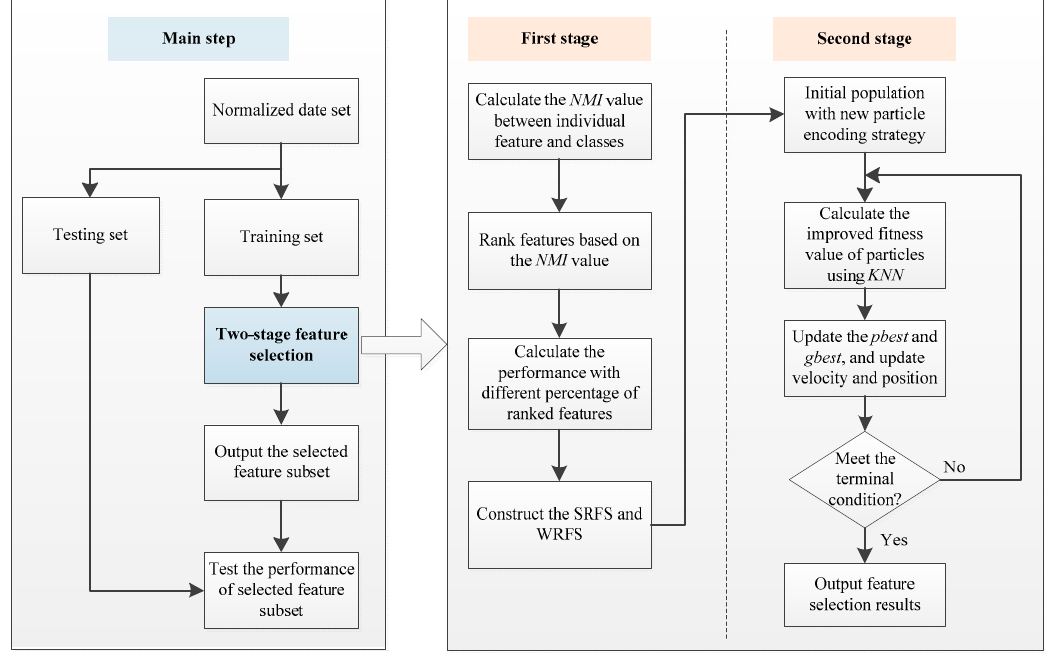
Figure 4. Flowchart of the proposed feature selection method.